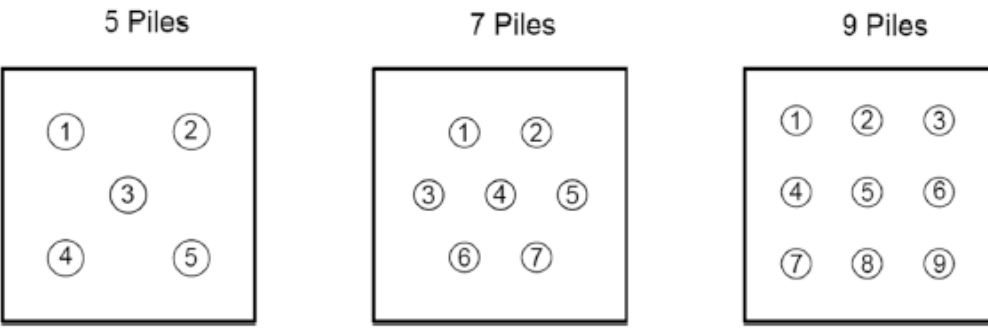
Figure 2. Pile group configurations considered in the finite element parametric study.